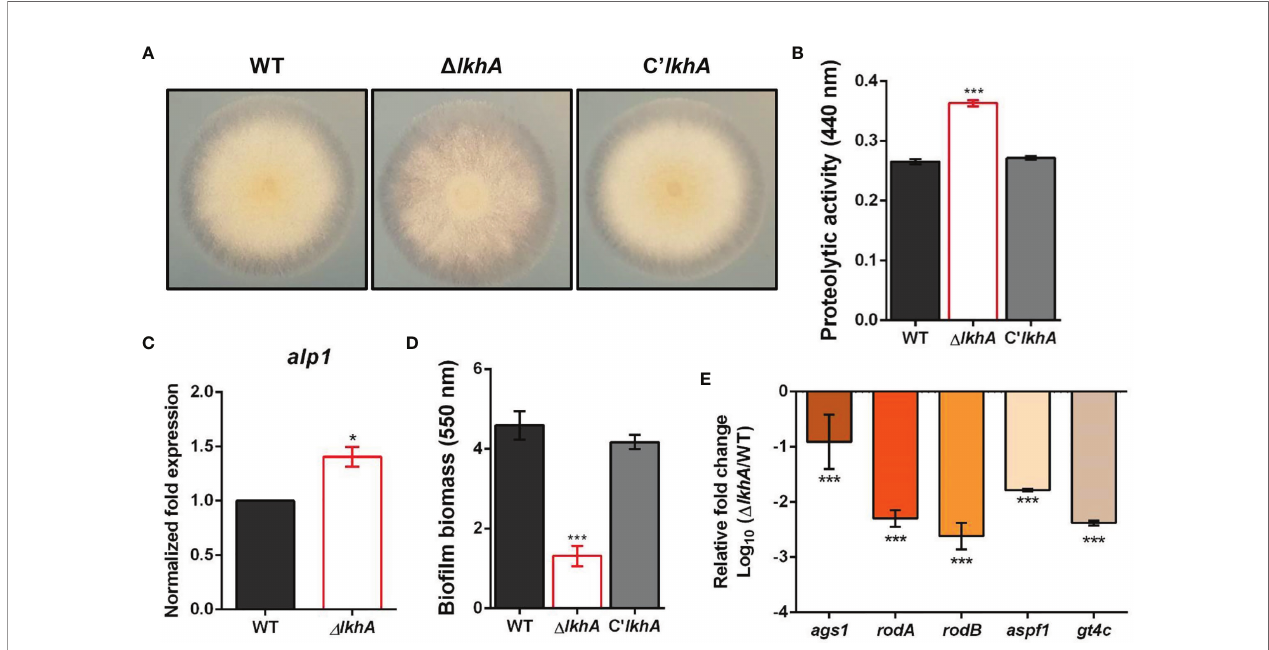
FIGURE 4 | Roles of Af LkhA in protease production and bio fi lm formation. (A) Halo formed at edge of colonies of WT, D A fl khA , and C ’ A fl khA strains. Each strains were point-inoculated on Czapek Dox medium containing 1% skim milk and incubated at 30°C. (B) Quanti fi cation of proteolytic activity. Supernatants were obtained from Czapek Dox broth (pH 7.3) containing 1% skim milk powder for 3 days at 30°C. Protein concentrations were calculated with a BCA Protein Assay Kit. Protease activity was measured using an azocasein assay. The experiments included six replicates (n = 6). ***P < 0.001. (C) Expression pattern of alkaline protease alp1 gene. Total RNA was extracted from mycelial balls incubated in Czapek Dox broth. RT-qPCR analysis was performed using 18S rRNA gene as an internal control. *P < 0.05. (D) Crystal violet staining assay. Bio fi lm formation was measured after 16 hrs of growth in GMM. The bio fi lms were stained with 0.01% crystal violet and dissolved in 30% acetic acid solution. The amounts of dye were measured by spectrophotometry at 550 nm (n = 10). ***P < 0.001. (E) Relative expression patterns of a -1,3-glucan synthase ( ags1 ), hydrophobins rodA , rodB , a ribonuclease ( aspf1 ), and a GAG synthase ( gt4c ). Total RNA was extracted from bio fi lm cultures. RT-qPCR analysis was performed